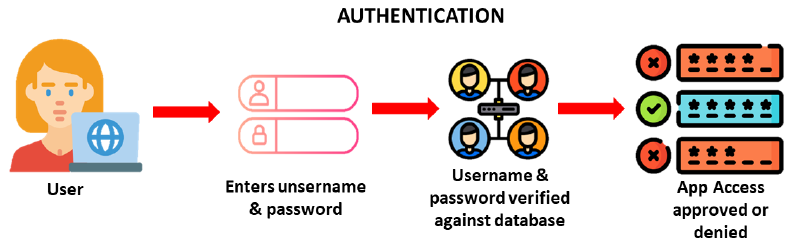
Figure 10. Authentication process in REOPEN platform.